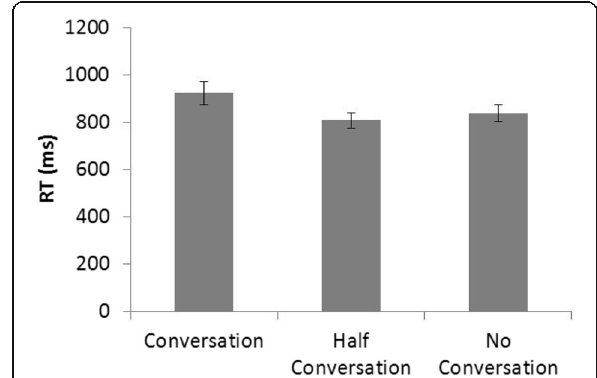
Fig. 8 Reaction times (RTs) for each condition in experiment 3. Error bars represent the standard error